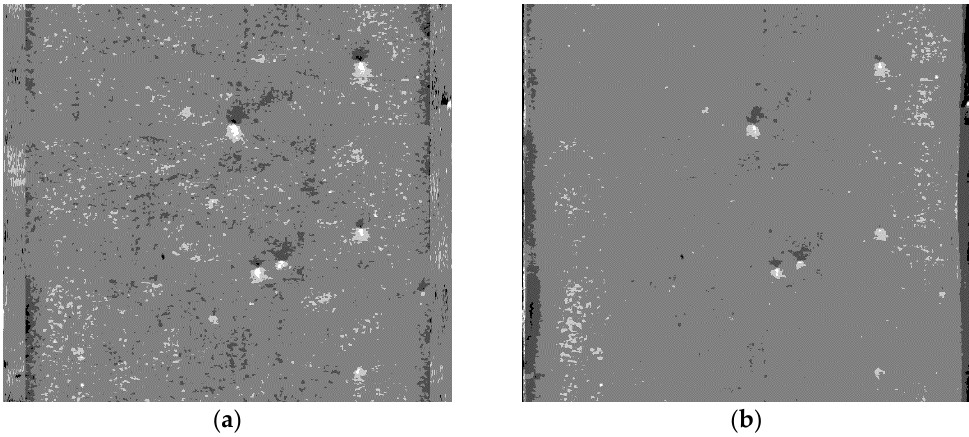
Figure 9. Results of defects extraction on image. ( a ) Result of partition defects extraction when MAF has 512 samples ( N = 512); ( b ) Result of traditional defects extraction without partition processing.